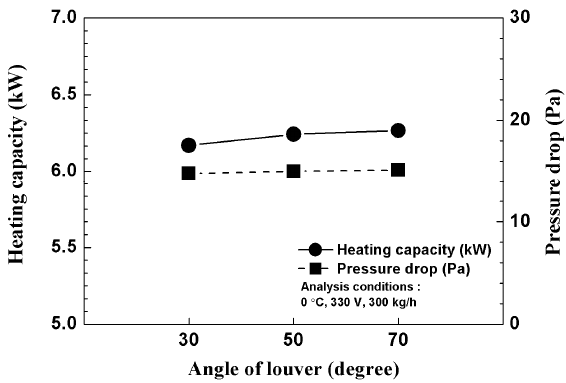
Figure 9. Heating capacity and pressure drop variations for di ff erent angles of the modified louver.